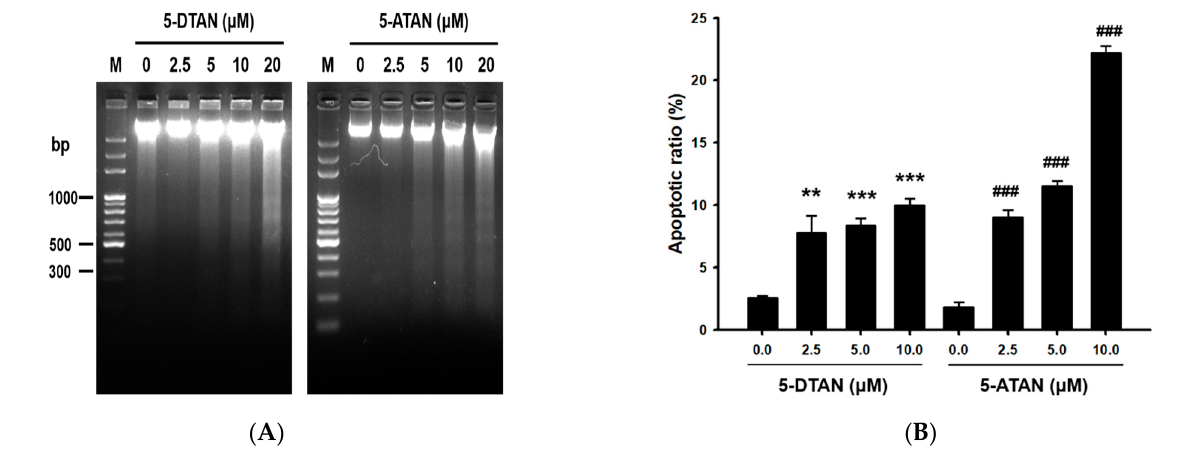
Figure 2. Effects of 5-DTAN and 5-ATAN on DNA fragmentation and apoptotic ratio in PC-3 cells. Cells were treated with various concentrations of 5-DTAN and 5-ATAN for 48 h. ( A ) DNA fragmentation was analyzed by electrophoresis in 2.0% agarose gel. ( B ) The apoptotic ratio of cells was calculated from the sub-G1 percentage of the cell cycle in PC-3 cells. Data are expressed as means ± SD ( n = 3). ** p < 0.01, *** , ### p < 0.001 vs. control group. Table 1. Effects of 5-DTAN and 5-ATAN on cell cycle distribution in PC-3